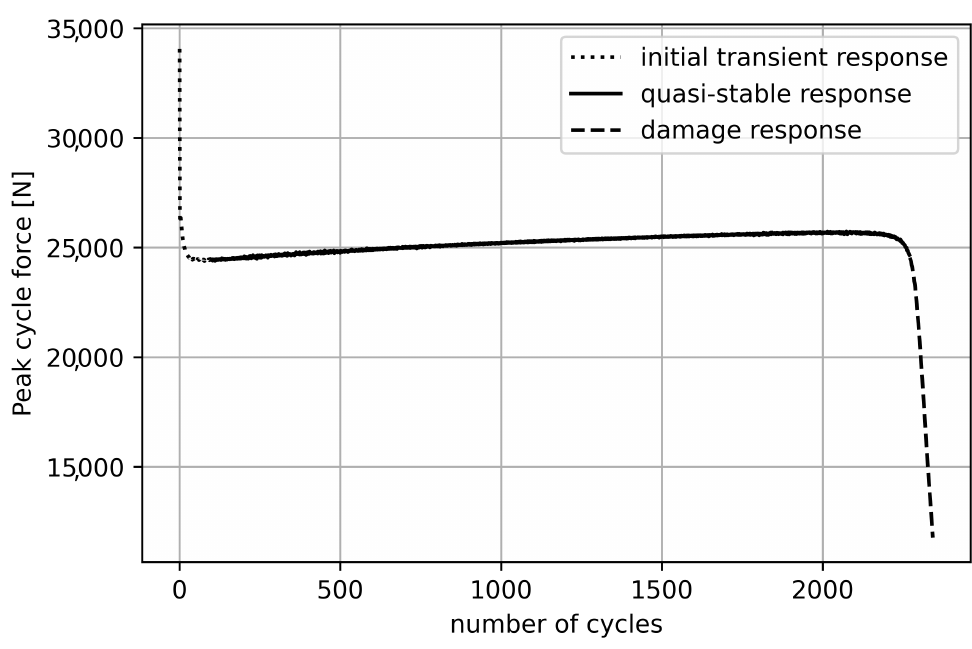
Figure 2. Peak-force evolution for S235 steel at (cid:101) a = 0.5%. Table 2. Non-linear kinematic material model’s